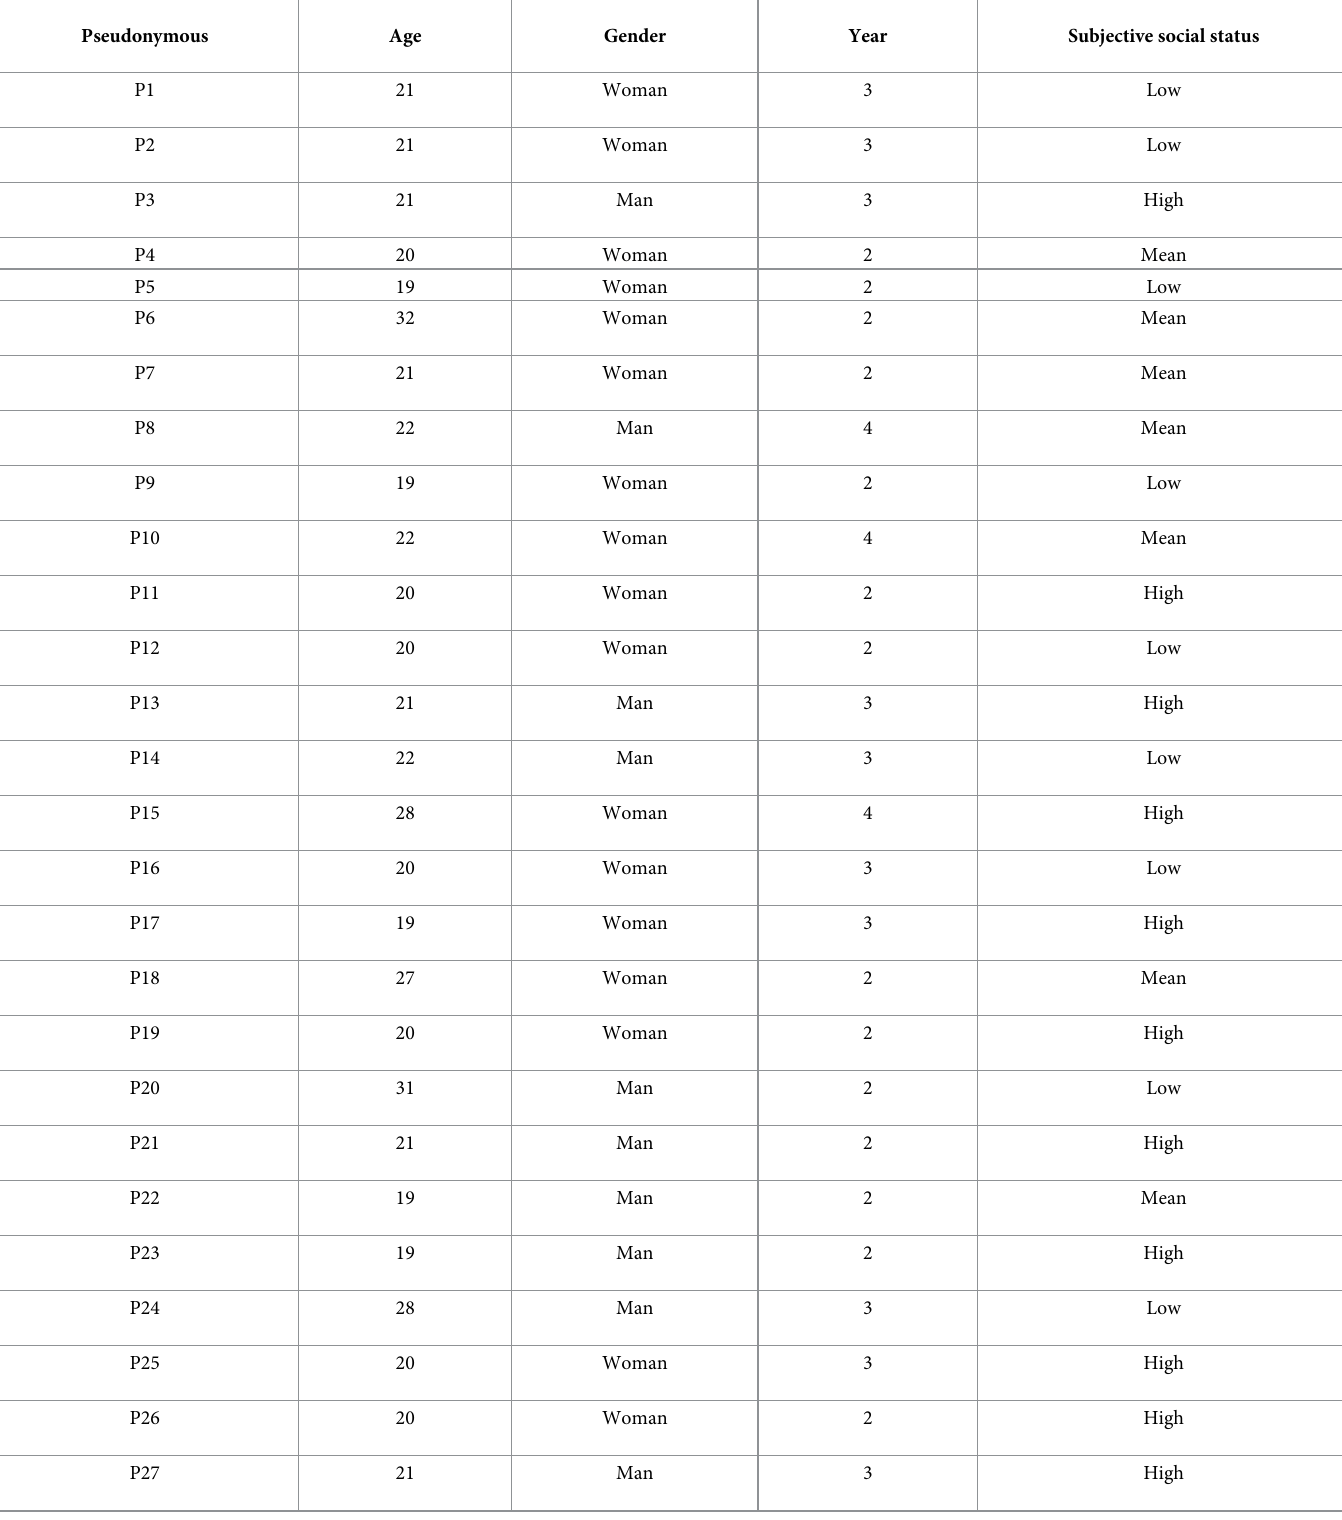
Table 1. Demographic data of